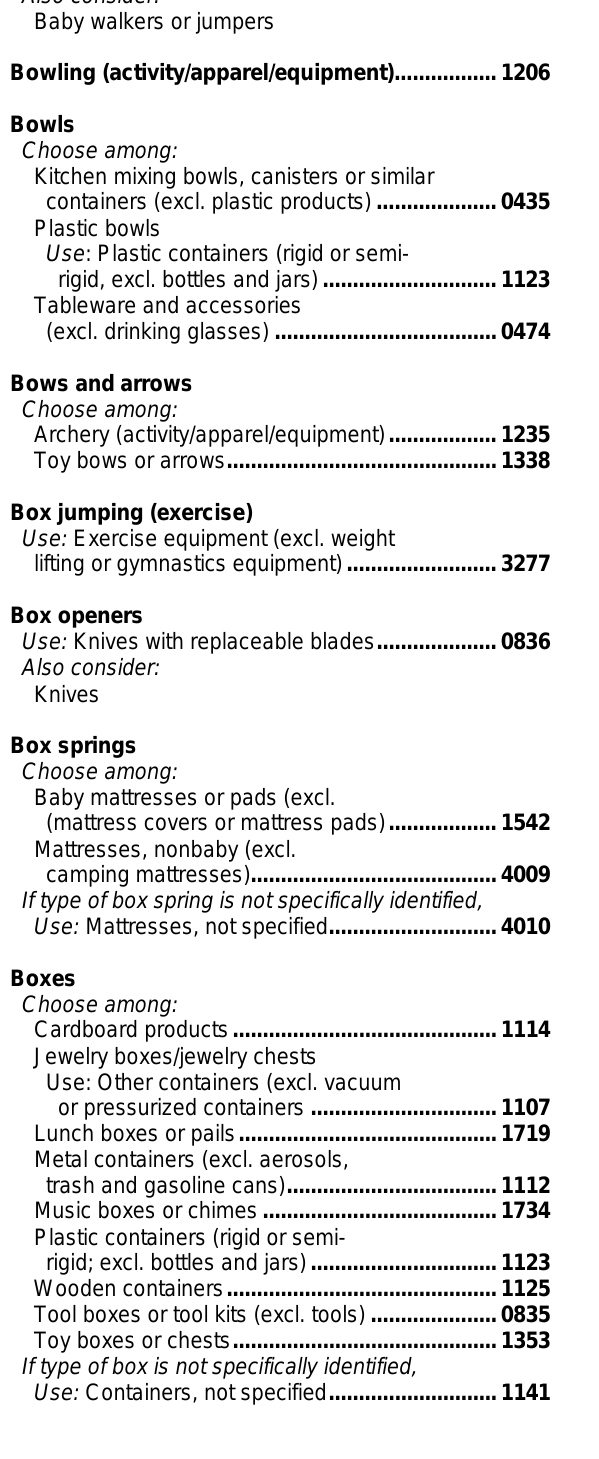
Bouncing seats, baby Choose among: